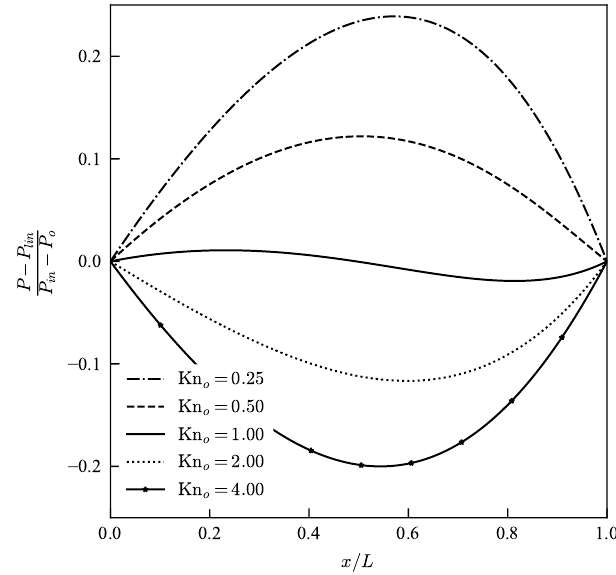
Figure 4. Variation in non-linearity of pressure profiles along the micro-channel for a pressure ratio P = 4, plotted for various outlet pressure conditions.